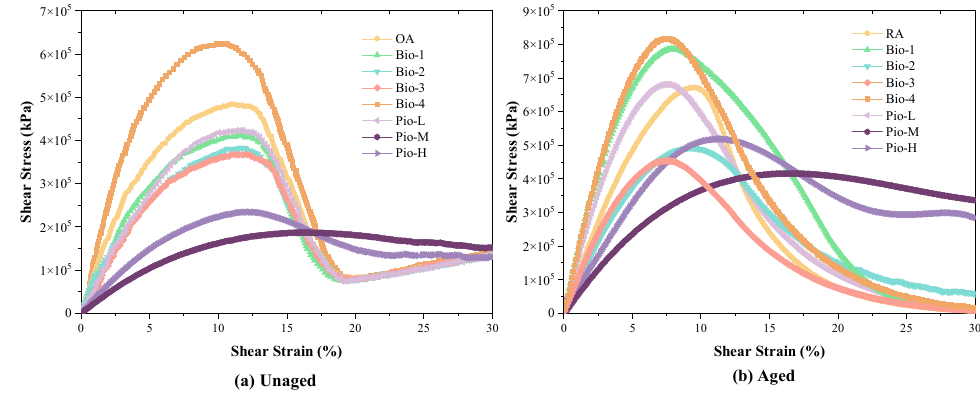
Figure 10. Shear strain versus shear stress curves of the LAS test of ( a ) unaged asphalts ( b ) aged asphalts. are ranked from best to worst as Pio-M, Pio-H, OA, Bio-3, Bio-2, Bio-1, Pio-L, and Bio-4,